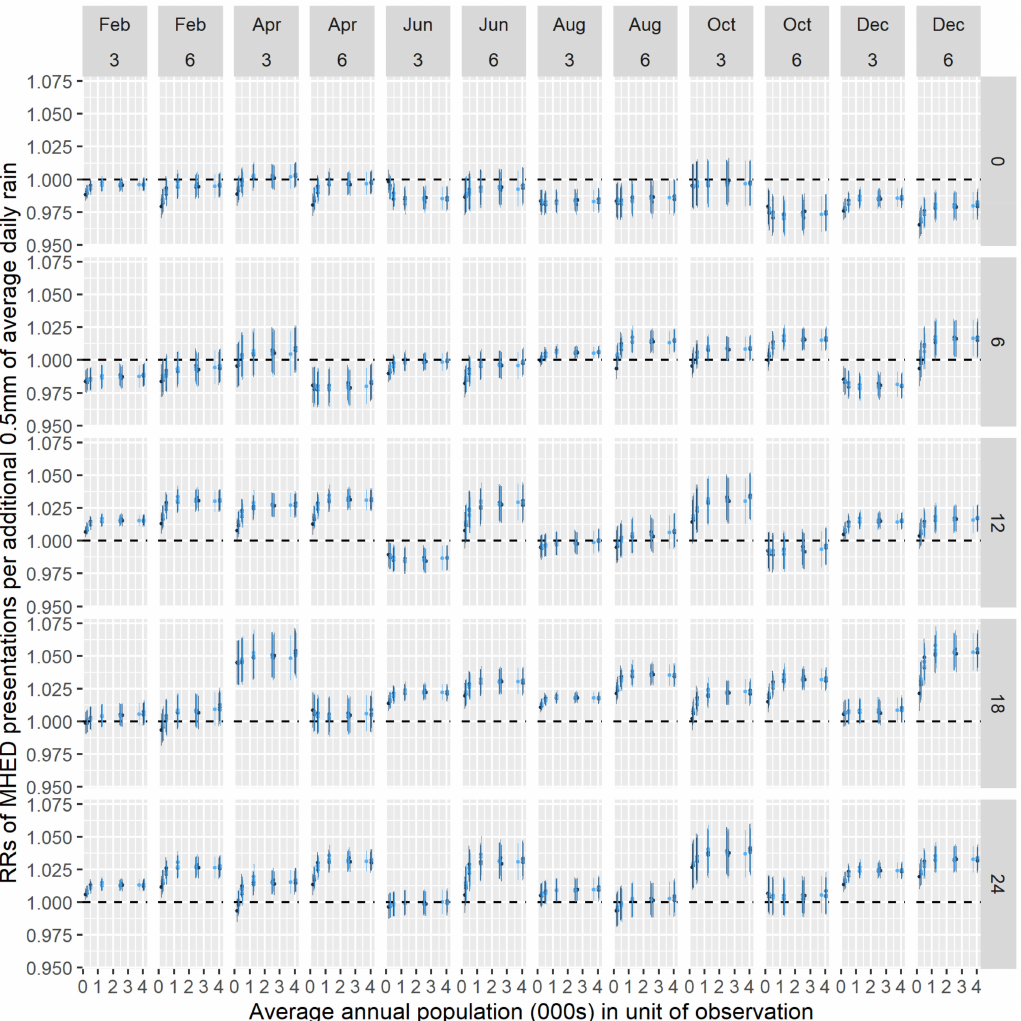
Figure 7. RRs ( dots ) and 95% credible intervals ( lines ) from models fitted to different spatial and temporal data preparations (males). Different shades of blue indicate estimates for different spatial zonations at each scale, in each panel. Black dots and lines indicate results from SA1-level analyses. MHED: mental health-related emergency